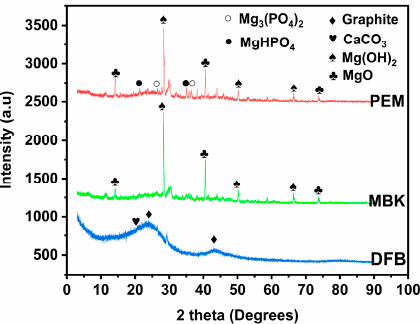
Figure 3. XRD spectra of untreated Douglas fir biochar (DFB), DFB treated with MgCl 2 · 6H 2 O + KOH solutions (MKB), and MBK treated with KH 2 PO 4 solution (PEM).